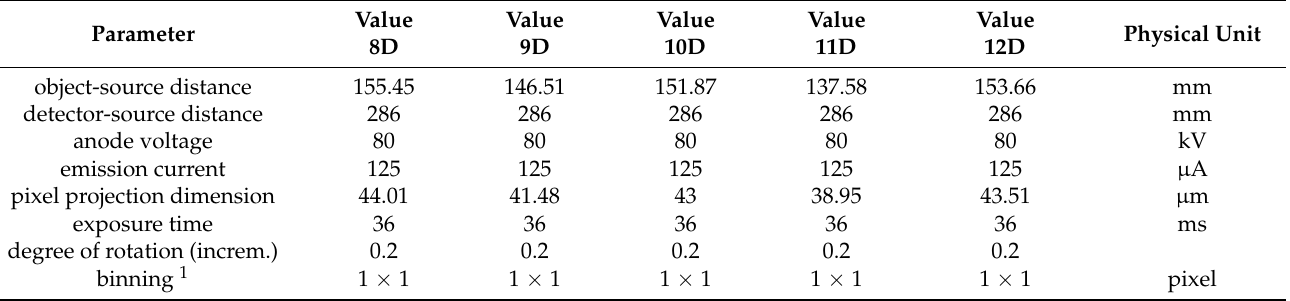
Table A8. Values of set parameters on SkyScan 1275.